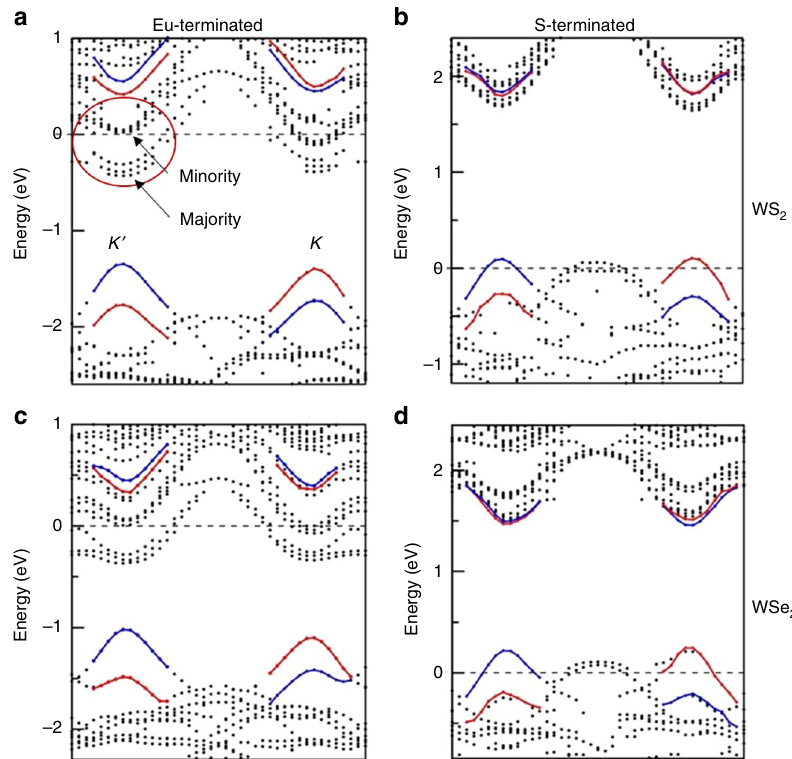
Fig. 5 Band structure. Band structure of WS 2 ( a , b ), and WSe 2 ( c , d ). Left panel: Eu-terminated EuS, right panel: S-terminated EuS. The W d -states are shown as red (spin-up) and blue (spin-down) bands. Notice that the shifts of the valence and conduction bands in cases of Eu- and S-terminations are in opposite directions due to the opposite polarity